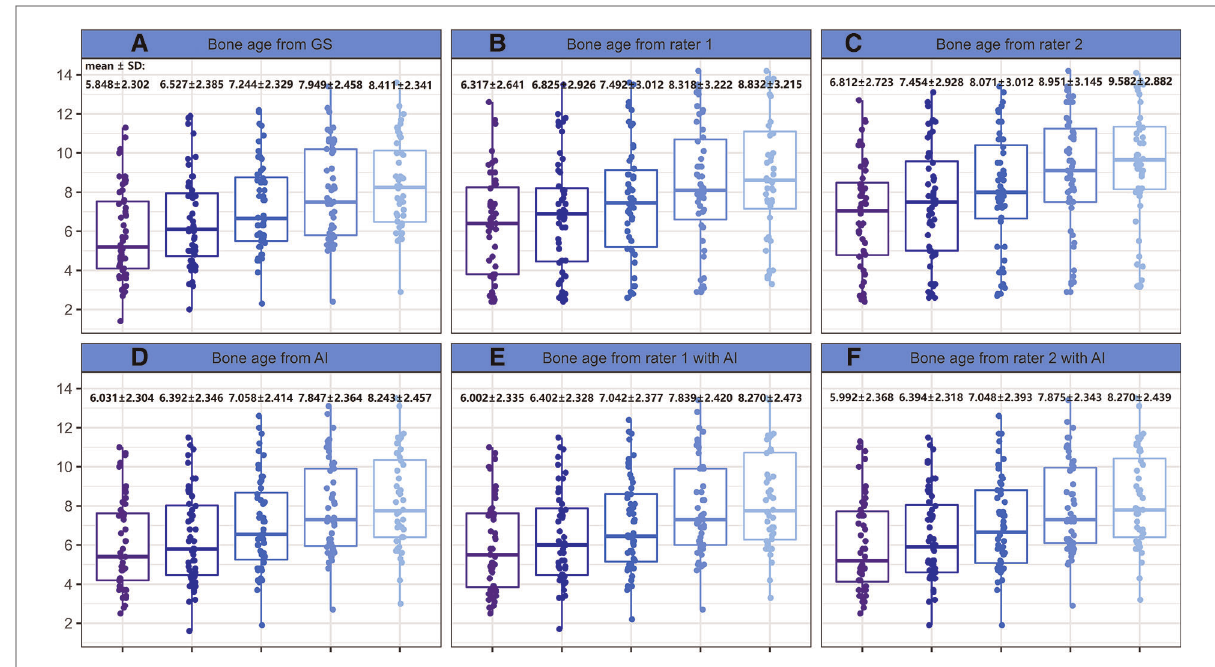
FIGURE 4 Boxplot of bone age as evaluated by different raters during the course of treatment. ( A ) Bone age from GS. ( B ) Bone age from rater 1. ( C ) Bone age from rater 2. ( D ) Bone age from AI. ( E ) Bone age from rater 1 with AI. ( F ) Bone age from rater 2 with